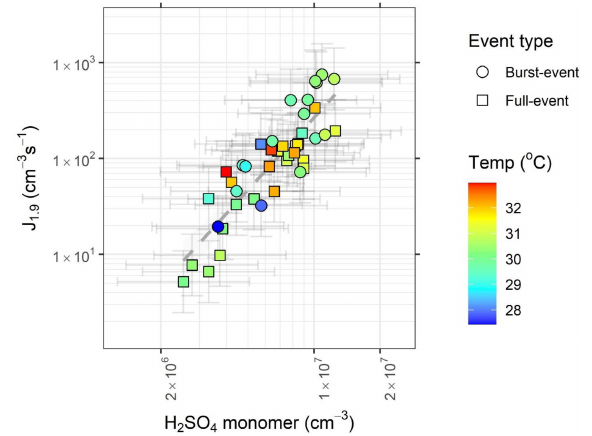
Figure 4. Formation rate ( J 1 . 9 ) plotted against sulfuric acid monomer concentration, coloured by condensation sink. Circles represent burst events and squares represent full events. Data are for hourly averages across NPF periods, typically within the hours 08:00–16:00CEST. Slope of the line = 4 . 9 × 10 − 5 s − 1 . Error bars represent systematic uncertainties in [H 2 SO 4 ] and J 1 . 9 .